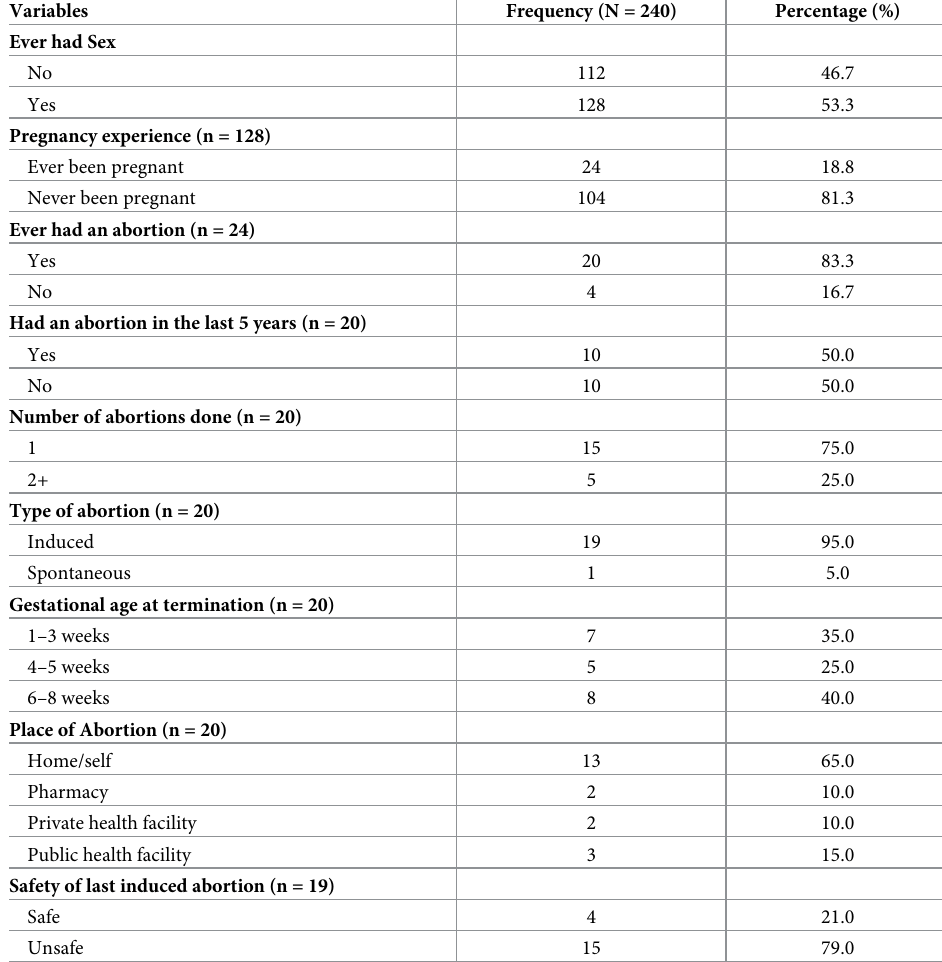
Table 2. Abortion experiences among female